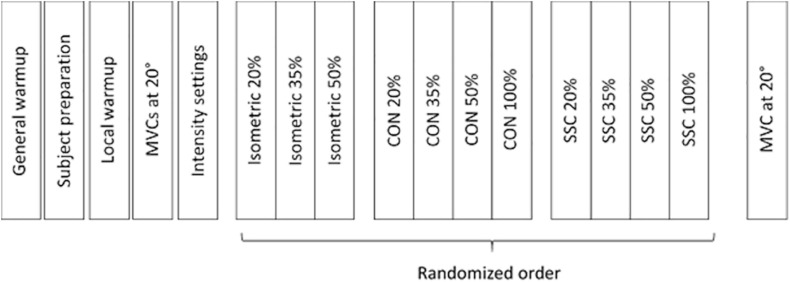
Experimental protocol work flow. The test protocol comprised maximal voluntary contractions (100%) and submaximal electrical stimulated contractions at 20%, 35%, and 50% of MVC.